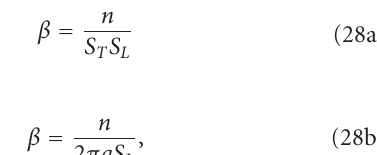
Figure 13: E ff ect of shear sti ff ness on stress distributions in rock mass (with faceplate).